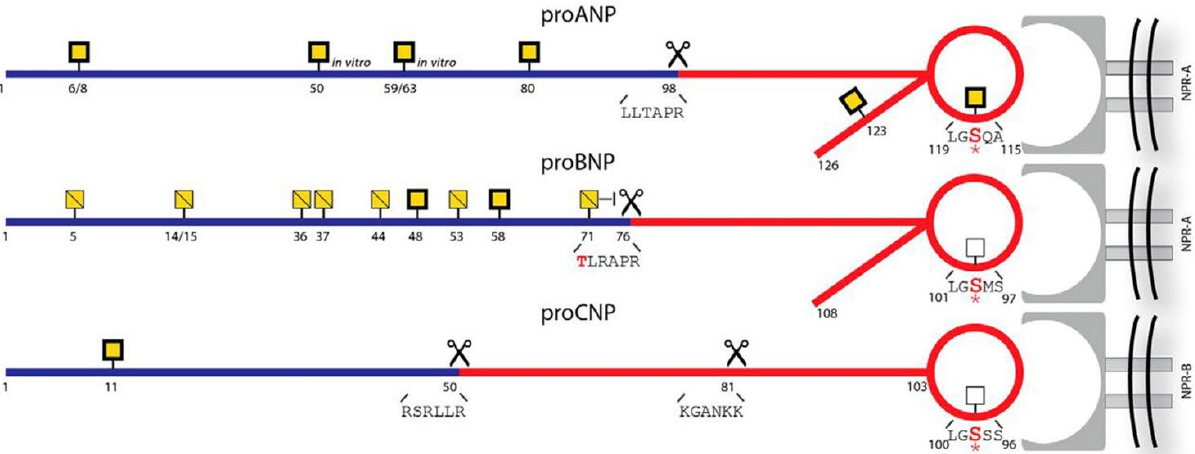
Figure 2. Natriuretic peptides and O-glycosylation (marked by yellow squares): Taken from [33] with permission.